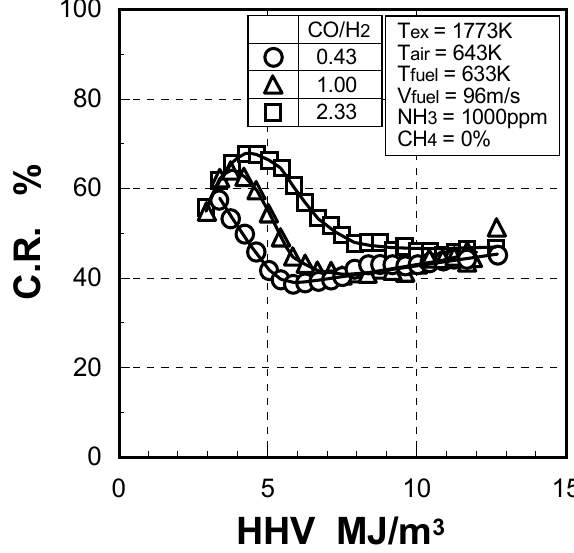
constituent in fuel on conversion rate of NH 2